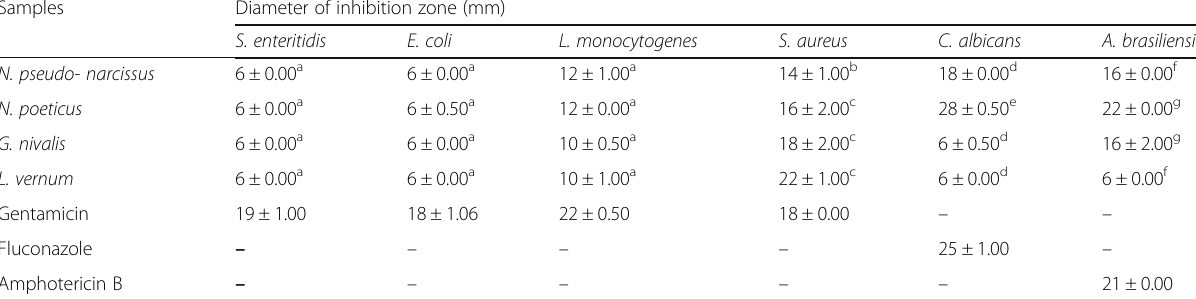
Table 3 Antimicrobial activity of the extracts Samples Diameter of inhibition zone (mm) S. enteritidis E.